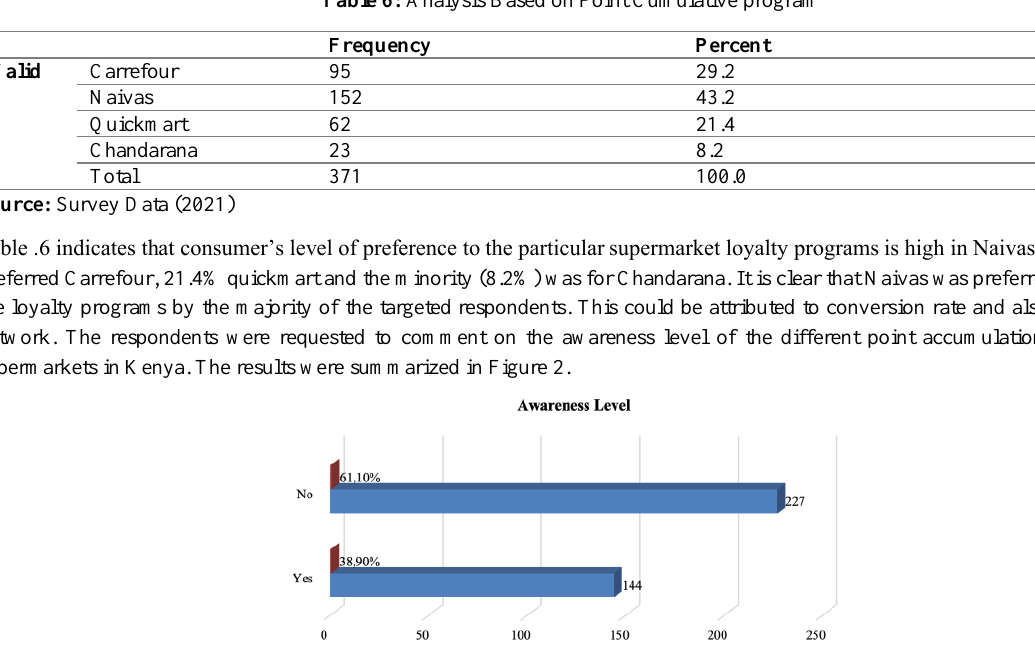
Table 6: Analysis Based on Point Cumulative program